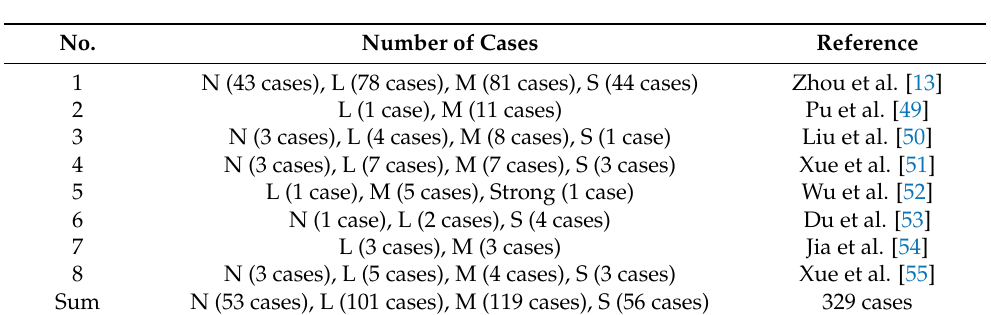
Table 2. The database source.